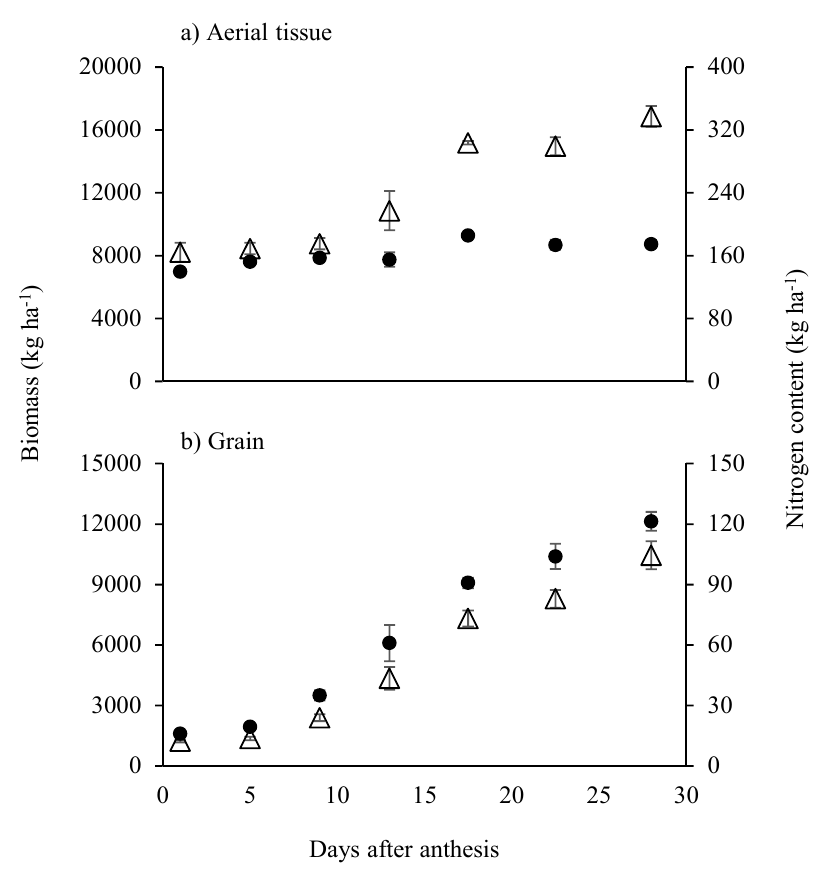
Figure 2. Accumulation of biomass (open triangles) and nitrogen (closed circles) in ( a ) aerial tissue and ( b ) grain of rice cv. IR64 grown under optimum conditions. Error bars represent SEM ( n = 3).